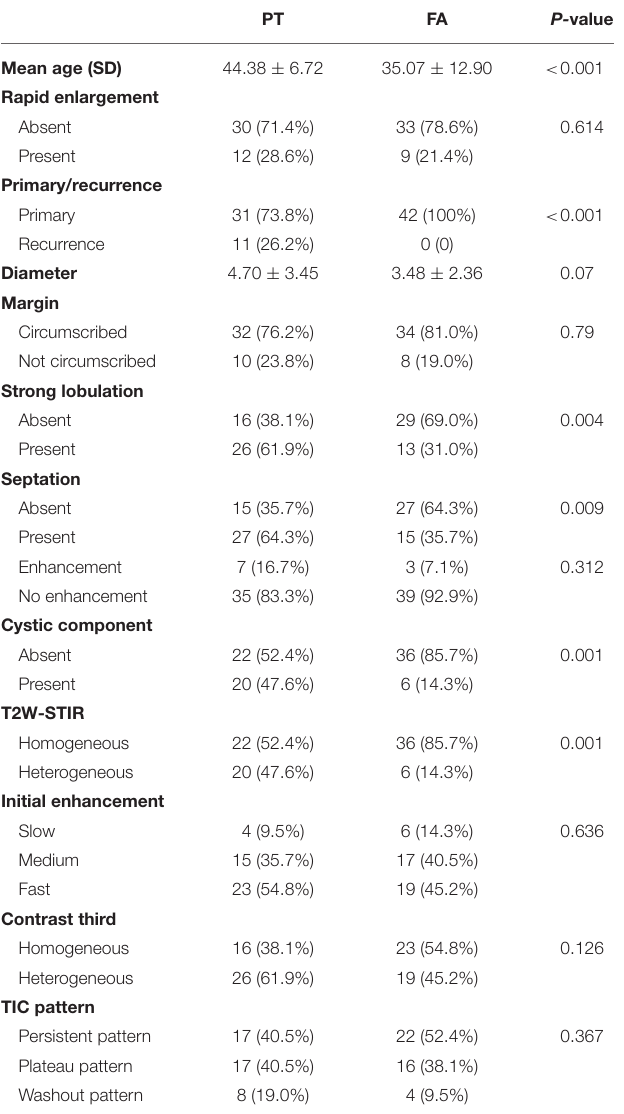
TABLE 2 | Clinical and conventional MRI features of phyllodes tumors and fibroadenomas.